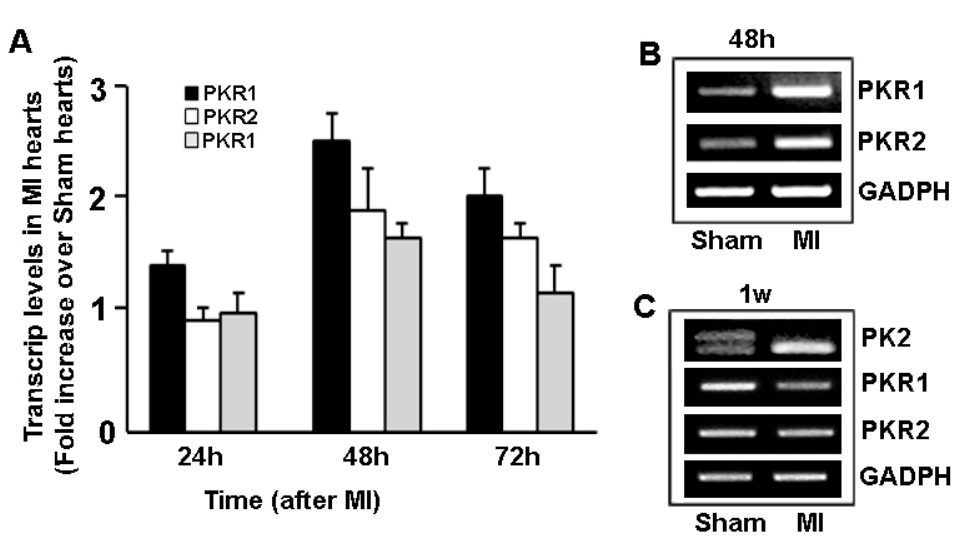
Figure 3. ( A ) Quantitative analyses of expression levels of prokineticin 2 (PK2) and its receptors, PKR1 and PKR2 in MI and sham operated mice hearts, 24, 48 and 72 hours after the operations. ( B ) Representative illustration of PCR analyses of the PKR1 and PKR2 transcripts 48h after MI. ( C ) Expression of transcripts of PK2 long form (PK2L, double bands) and short form (single bands), and PKRs in MI and sham operated hearts one week after MI. The authors would like to apologize for any inconvenience caused to the readers by these changes.